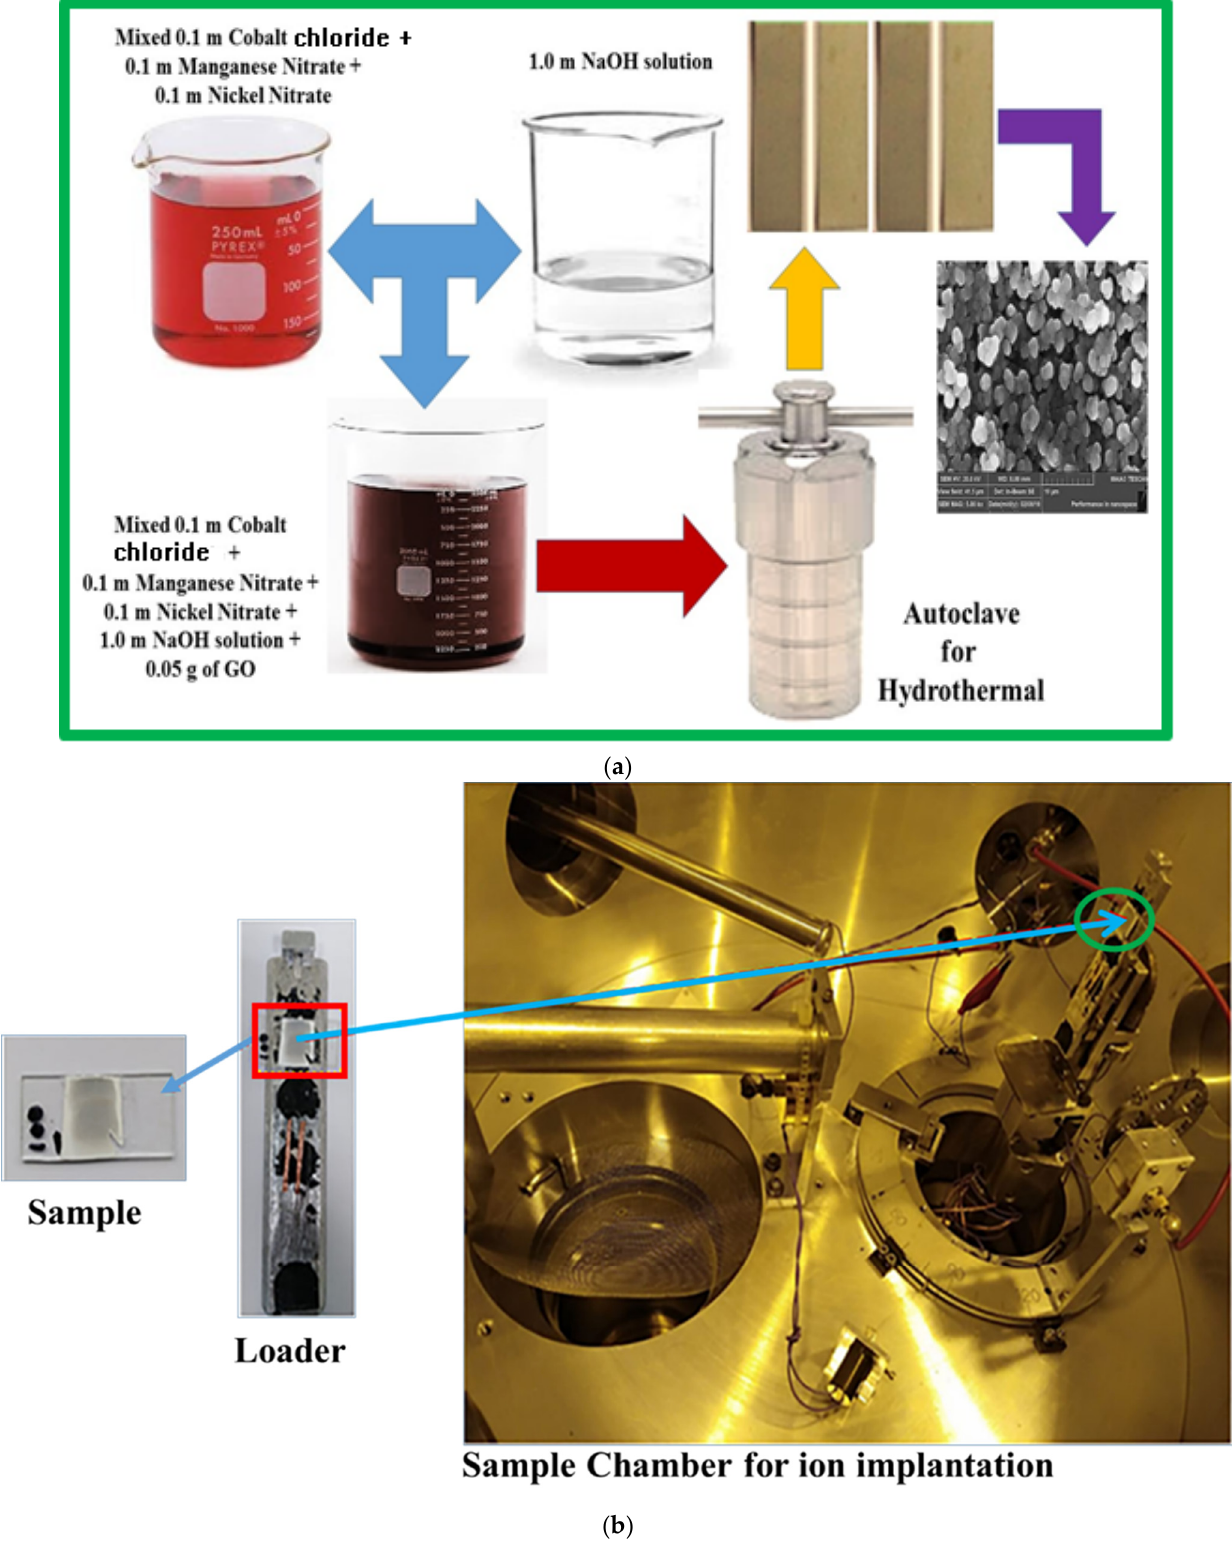
Figure 1. ( a ) Co 3 O 4 @MnO 2 @NiO/GO synthesis procedure. ( b ) Schematic procedure for ion implantation. Electrodes of synthesized Co 3 O 4 @MnO 2 @NiO/GO composites were placed in the 2.3. Irradiation of Co 3 O 4 @MnO 2 @NiO/GO Electrodes sample holder of a loader inside the implantation chamber [54] and radiated using 8.0